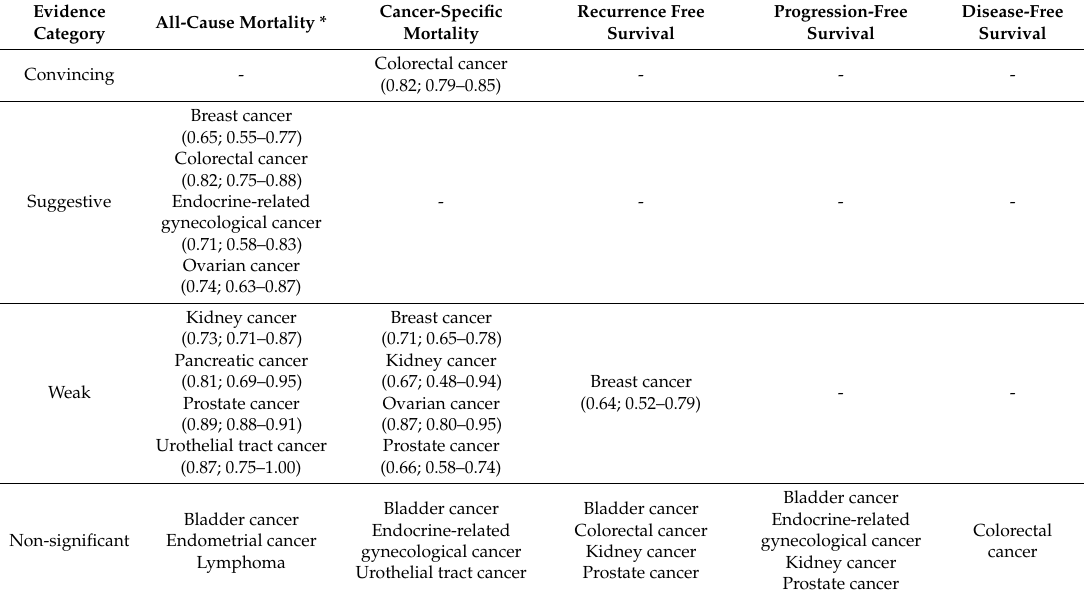
Table 5. Evidence of association between statin use and mortality or survival